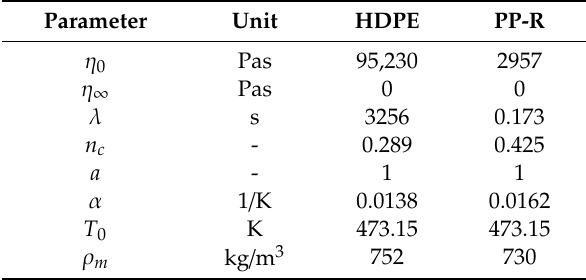
Table 1. Material parameters ( ρ m is the melt density at 200 ◦ C and 200 bar).